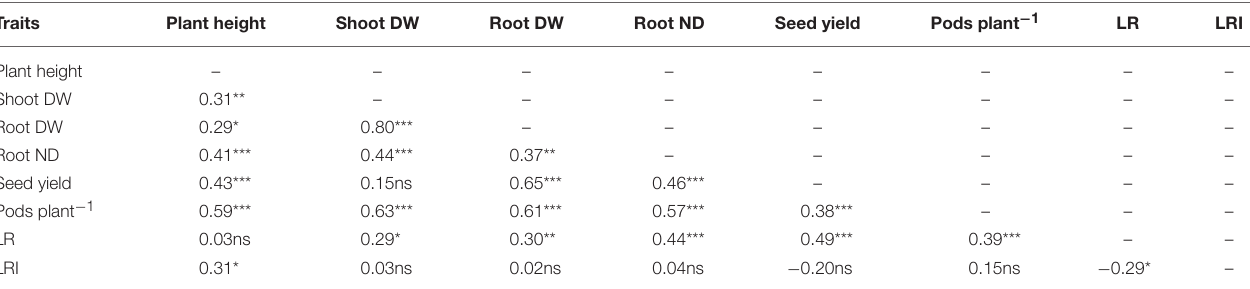
TABLE 5 | Correlation coefficient ( r ) among plant height, shoot dry weight, root dry weight, root neck diameter (ND), 1,000-seed yield, number of pods per plant, lodging resistance (LR), and lodging resistance index (LRI) in rapeseed.